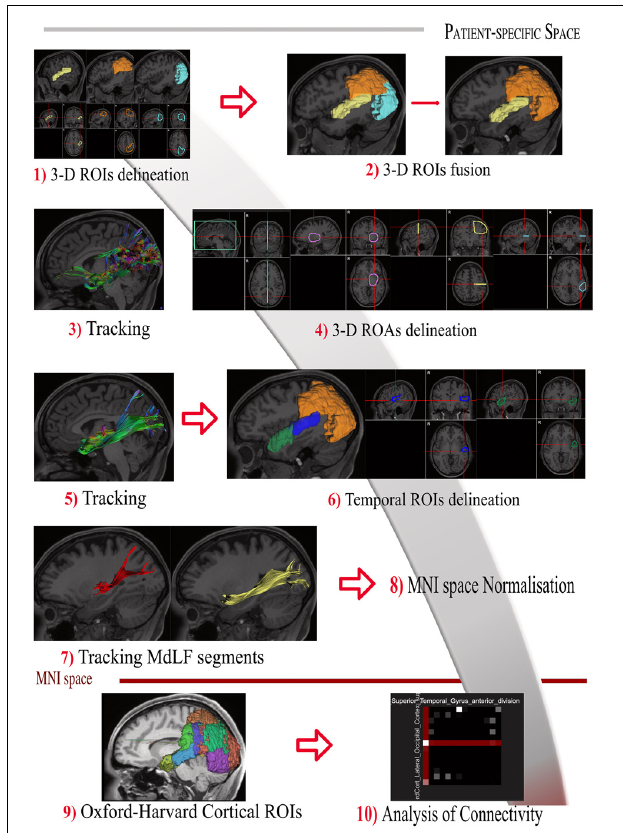
FIGURE 1 | Tractography protocol for the identification and segmentation of MdLF in 10 steps. (Step 1) The 3-D ROIs are drawn delineating the entire STG (yellow), parietal lobe (orange) and occipital lobe (light blue) displayed with 3D reconstructions and 3-axis projection. (Step 2) Parietal and occipital lobe are merged in one ROI to delineate the entire temporo-parieto-occipital connectivity. (Step 3) The whole cortical subcortical connectivity of the temporo-parieto-occipital region was then revealed, displayed here in sagittal projection and with directional colors. (Step 4) The 3D orientation allows us to identify MdLF fibers in their central longitudinal portion (stem), as well as other close white matter tracts. Fibers crossing or close to the midline were identified and subtracted with the green region of avoidance (ROA). The IFOF fibers were identified as medial and crossing the external capsule and excluded with the purple spheroidal ROA; Fibers of the acoustic radiation were found to be medial and perpendicular to the MdLF stem fibers at the level of the aTTG. They were also excluded if present with the posterior portion of the purple spheroidal ROA including the postero-lateral portion of the thalamus and basal ganglia. Fibers from the arcuate fasciculus (AF) were identified as lateral and almost perpendicular with respect to the MdLF stem fibers; the horizontal component of the SLF was lateral and dorsal in respect to the MdLF stem fibers. Both these two bundles were excluded with the Yellow ROA placed at the level of the central sulcus. The vertical portion of the SLF was identified as perpendicular, lateral and posterior in respect to the MdLF stem and excluded with the light blue ROA. In case ILF fibers were identified ventral and lateral in respect to the MdLF stem fibers the light blue ROA was extended to the MTG and ITG. (Step 5) Once the whole MdLF course was isolated, each MdLF temporal termination was identified using an additional one-ROI approach in each cortical/subcortical territory. (Step 6) The temporal region was then divided into two sub-regions to reveal the two components of MdLF. The posterior temporal region (blue) included the posterior portion of the superior temporal gyrus, aTTG, and PT. The anterior temporal region (green) included the anterior STG (aSTG), the planum polare